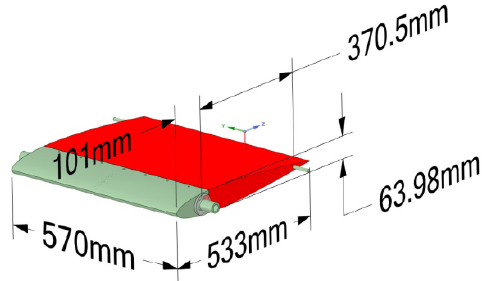
Figure 3. Test model and size.